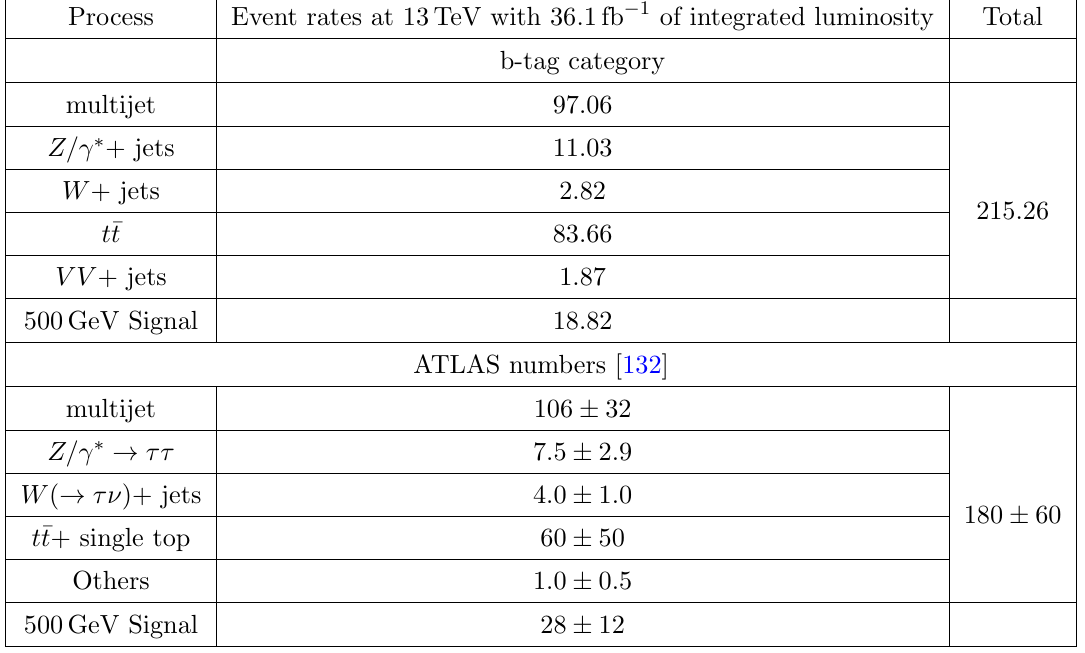
Table 21 . Comparison table for the (cid:28) h (cid:28) h channel in the b -tag category. azimuthal angle separation between the leading and the sub-leading (cid:28) jets is required to be (cid:1) (cid:30) ( (cid:28); (cid:28) ) > 2 : 7. Furthermore, we require m vis :